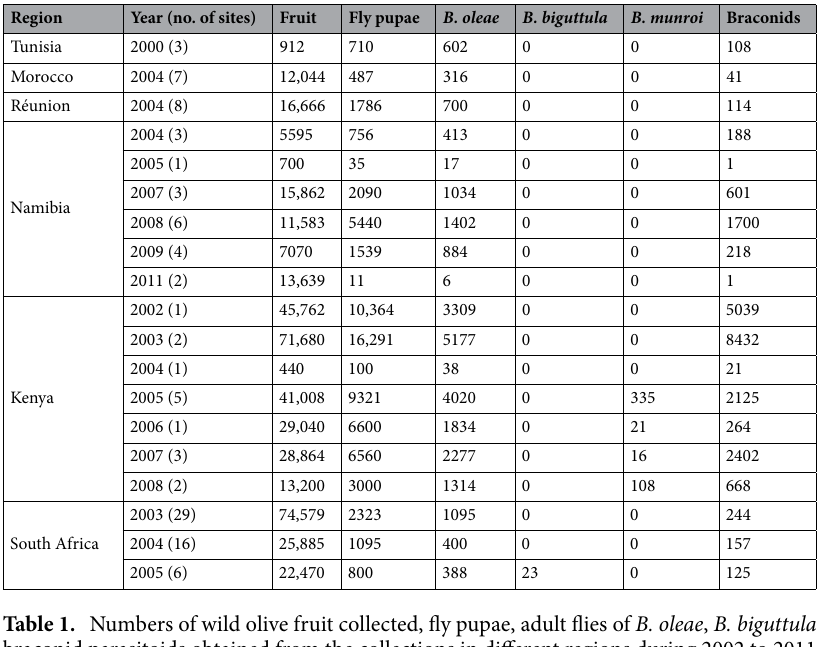
Table 1. Numbers of wild olive fruit collected, fly pupae, adult flies of B. oleae , B. biguttula and B. munroi, and braconid parasitoids obtained from the collections in different regions during 2002 to 2011.